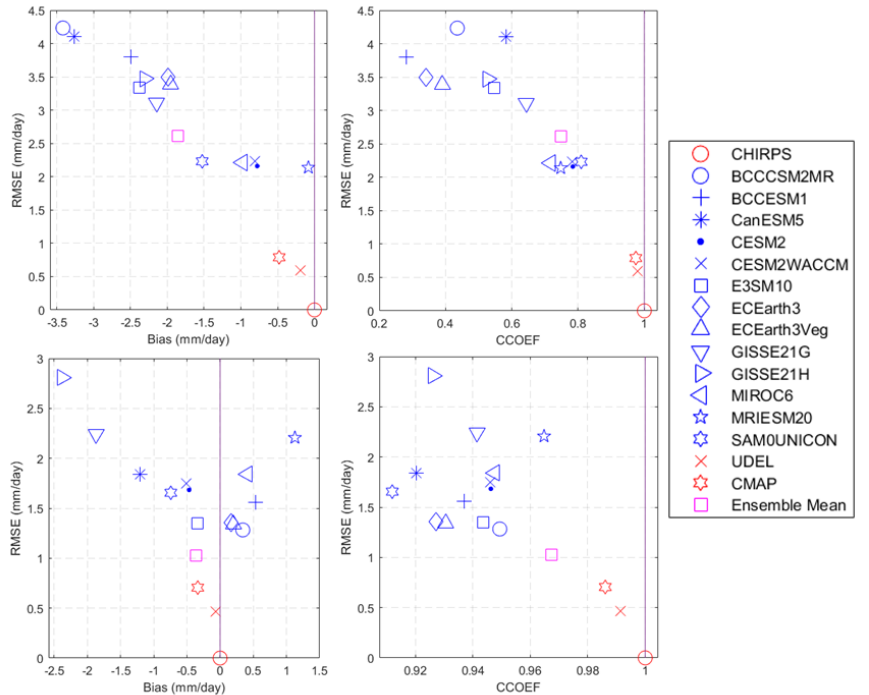
Figure 7. RMSE versus bias ( left ) and RMSE versus correlation coefficient ( right ) for 1981–2014 (mm day − 1 ) for northern Amazon (NAZ—( top ) panels) and southern Amazon (SAZ—( bottom ) panels).